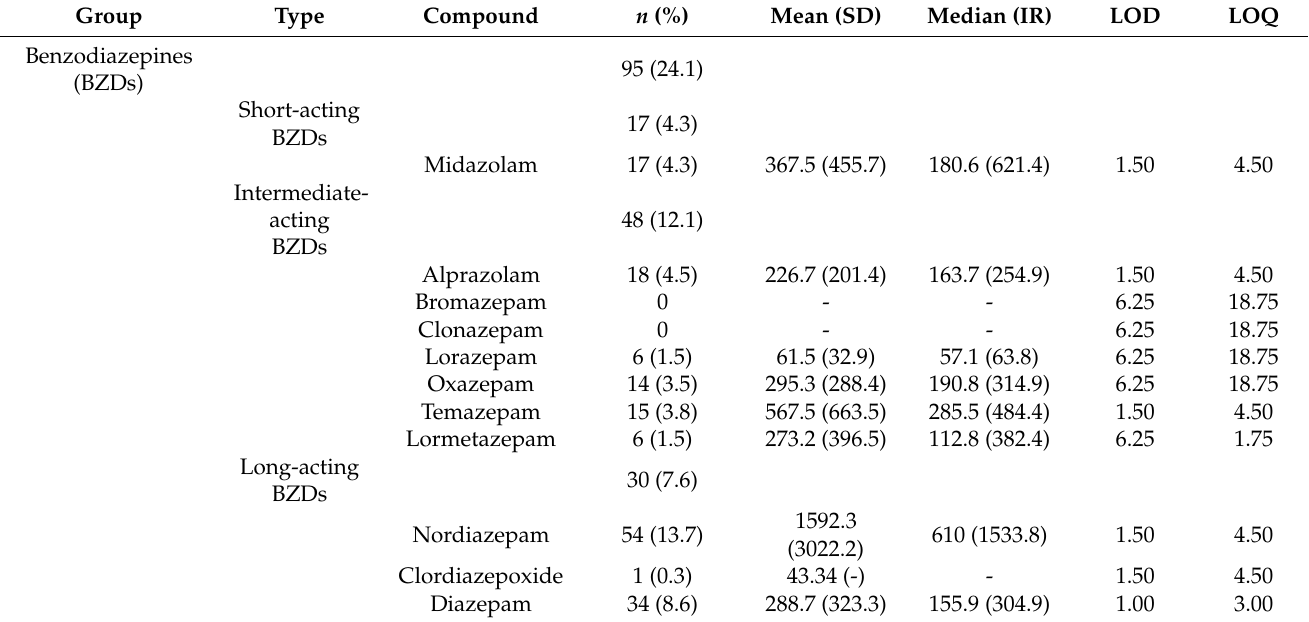
Table 2. Mean (and standard deviation) and median (and interquartile range: percentile75– percentile25) in ng/ml, limit of detection (LOD) limit of quantitation (LOQ) in ppb (ng/ml),